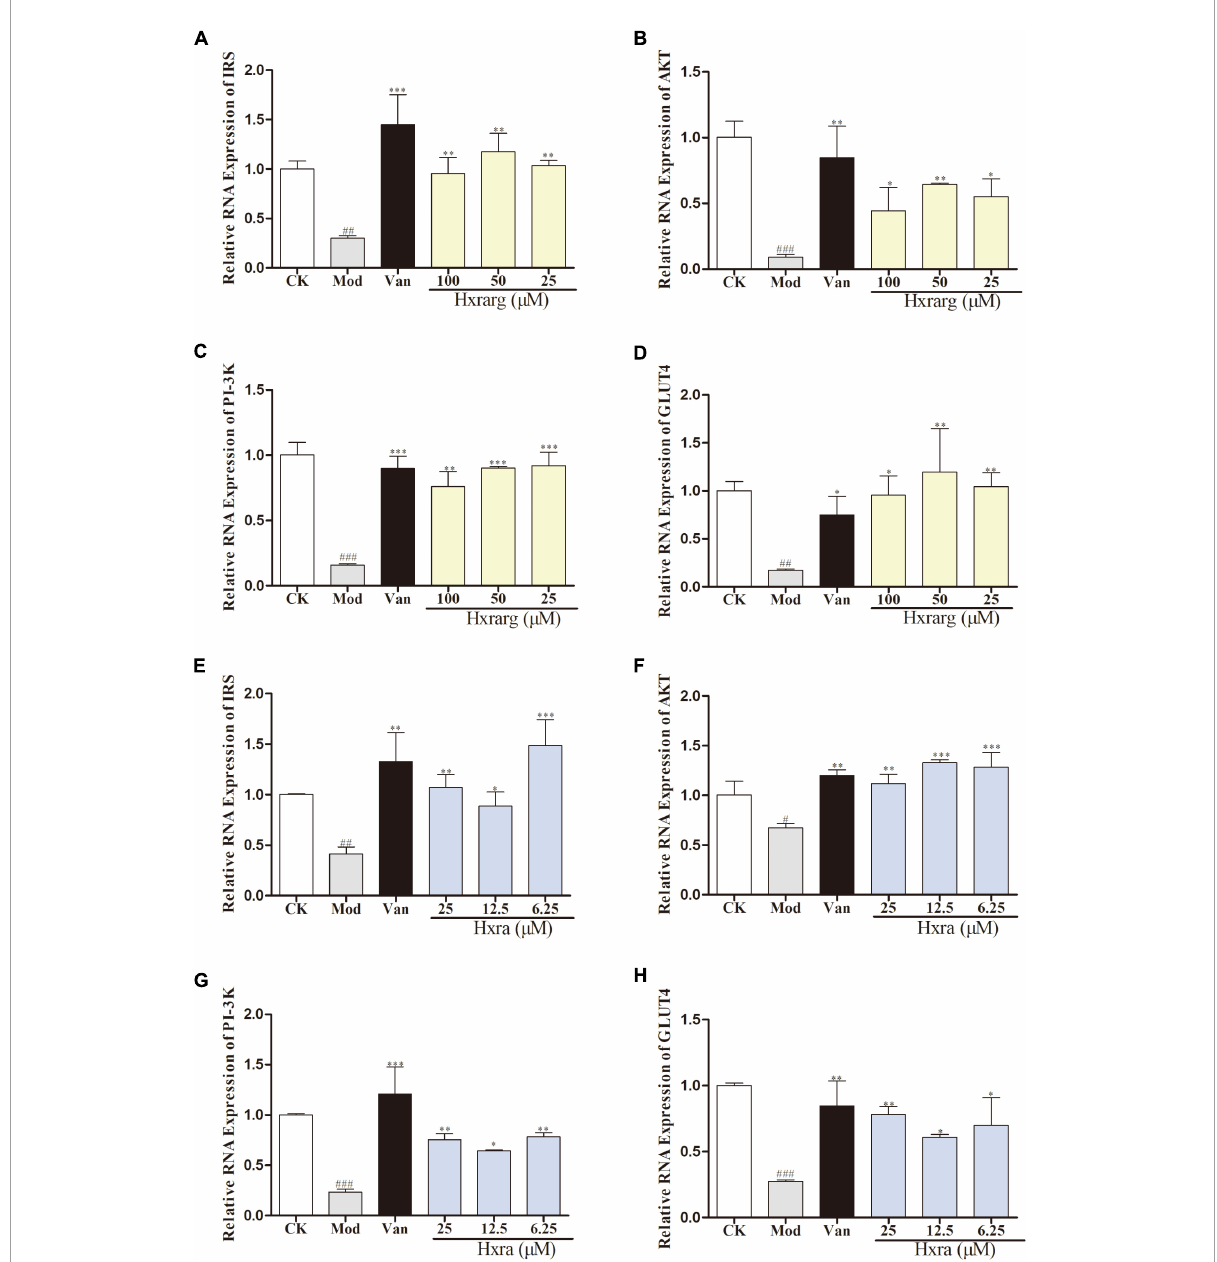
FIGURE9 The effects of Hxrarg (A–D) and Hxra (E–H) on mRNA transcription. (A,E) IRS mRNA; (B,F) AKT mRNA; (C,G) PI-3K mRNA; and (D,H) GLUT4 mRNA. Compared with control group, ## P < 0.01, ### P < 0.001; compared with model group, ∗ P < 0.05, ∗∗ P < 0.01, ∗∗∗ P <